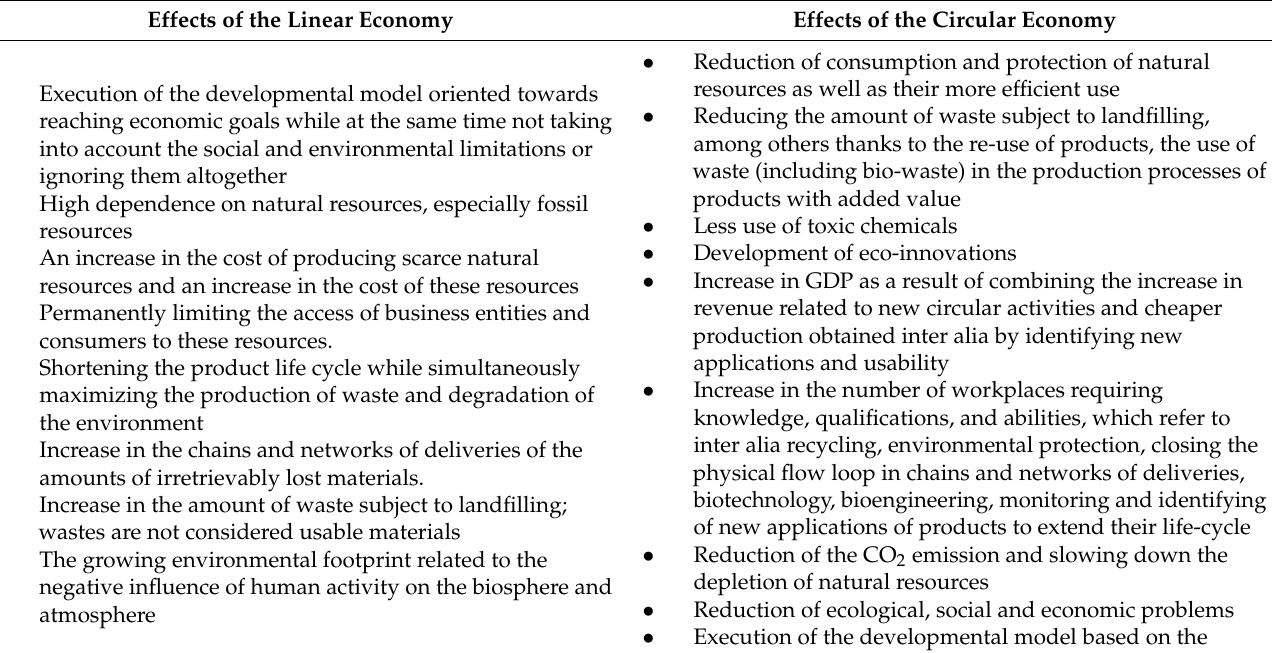
Table 1. Linear economy vs. circular